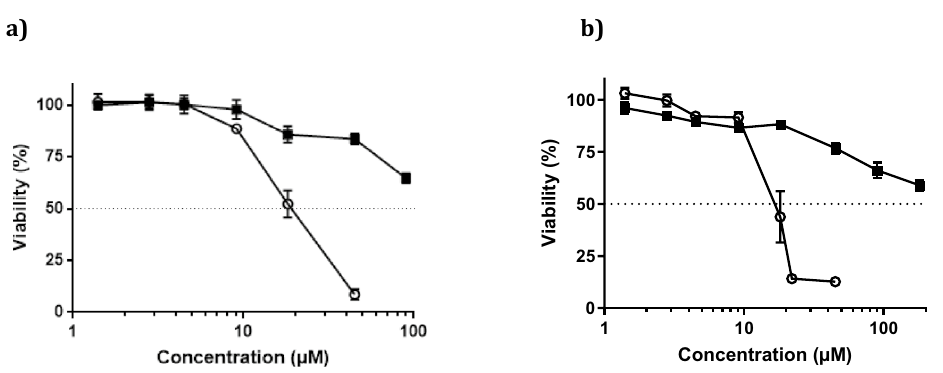
Figure 5. Concentration-dependent effects of ERα17p (- ■ -) and peptide 2 (- ○ -) on cells viability (in %), in ( a ) MCF-7 and ( b ) HS578T breast cancer cells. Concentrations are expressed in μM. Each experiment is performed in triplicate (N = 3). Standard errors of the means (± SEM) are specified.